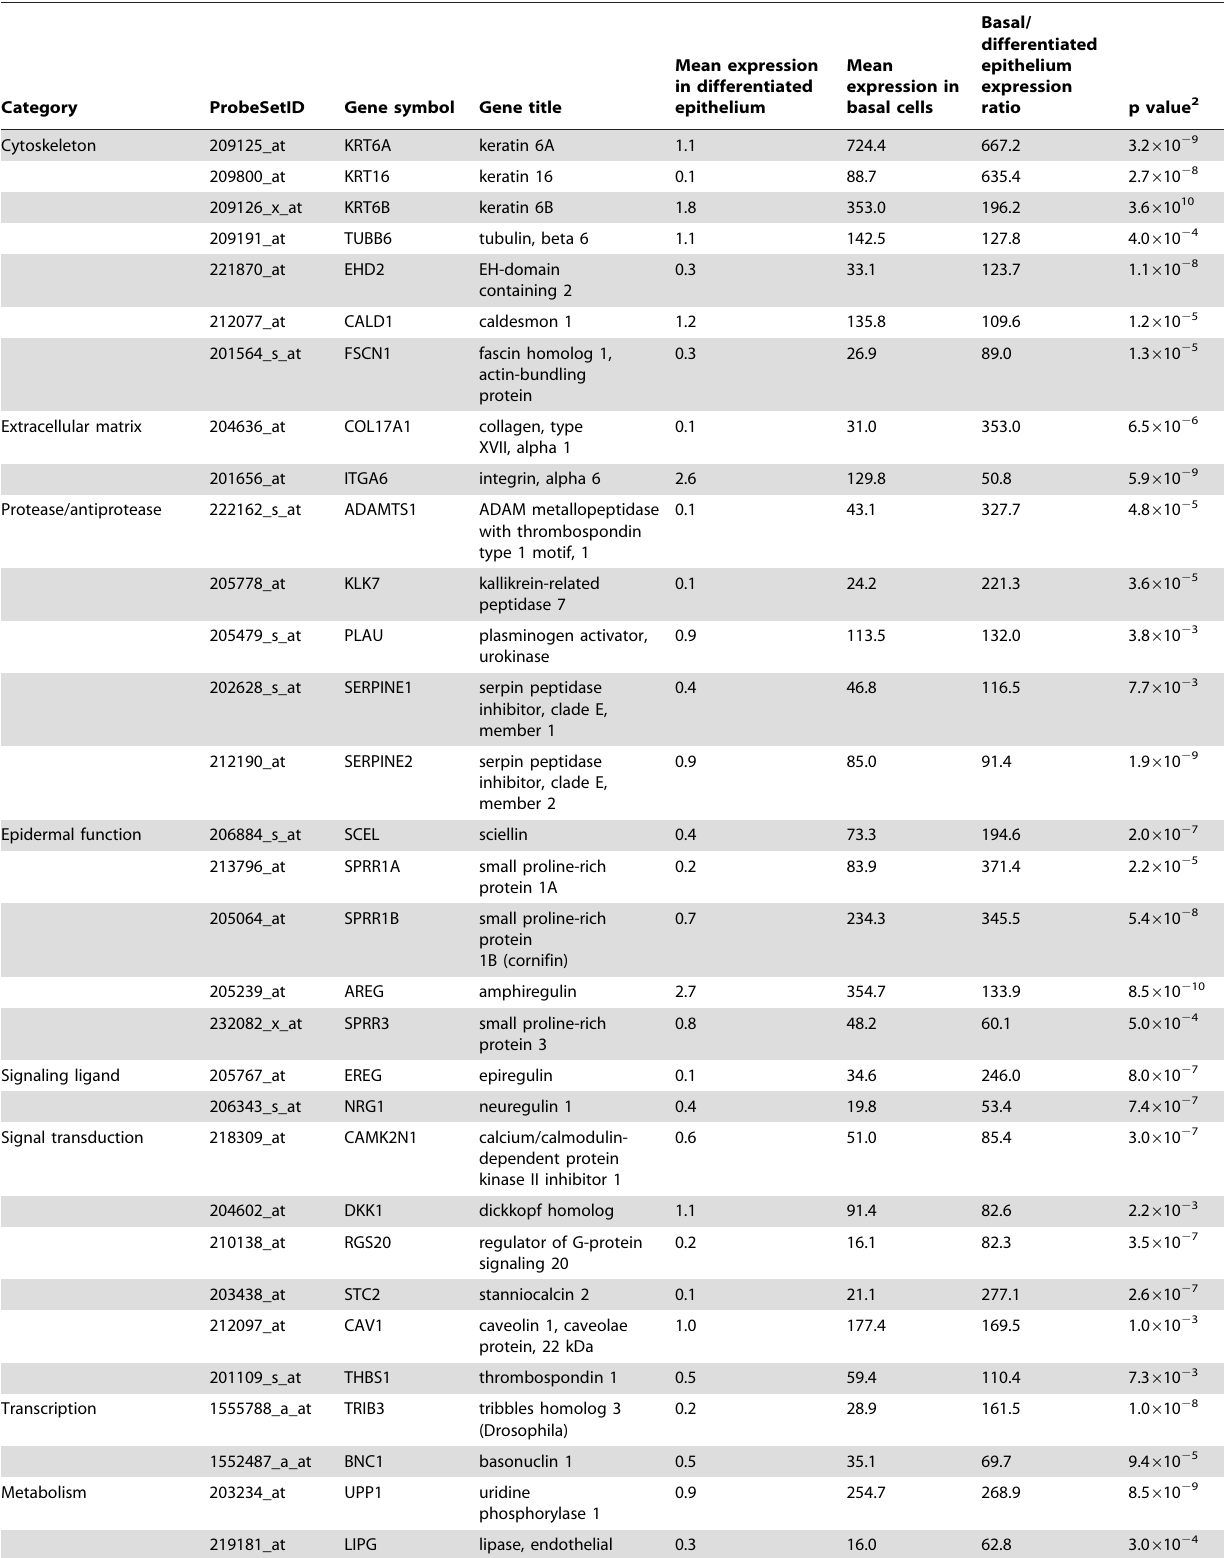
Table 1. Top 45 Human Airway Basal Cell-enriched Genes.